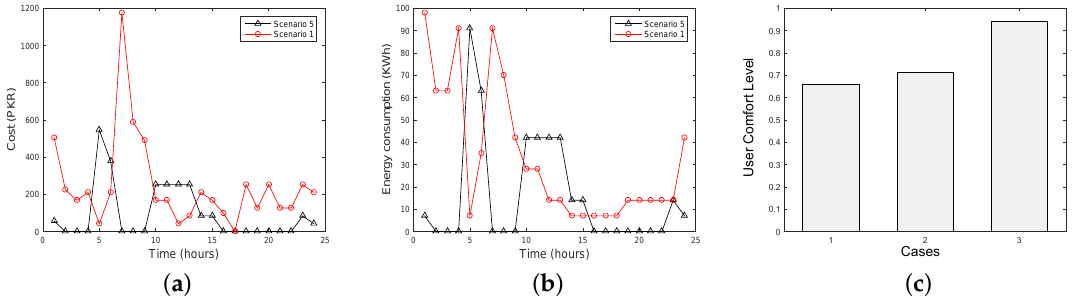
Figure 9. EMS with the combination of the evolutionary algorithm (BPSO) and storage device (Scenario 5). ( a ) Cost profile (Scenario 5); ( b ) load profile (Scenario 5); ( c ) UCL when: Case 1: α , ζ = 0.3,0.7; Case 2: α , ζ = 0.5,0.5; Case 3: α , ζ = 0.7,0.3.